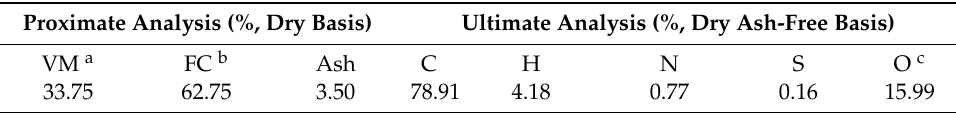
Table 1. Proximate and ultimate analyses of raw coal.